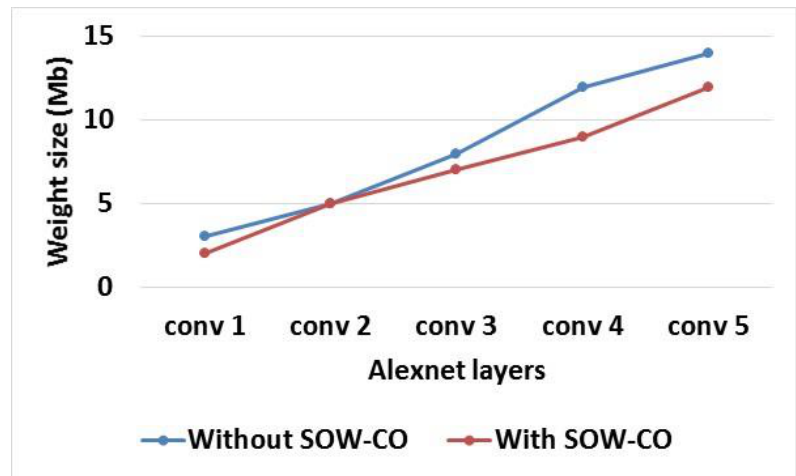
Figure 10. Graphical illustration of weight size for Alexnet. Table 3. Analysis of feature map and weight sizes for VGG16.